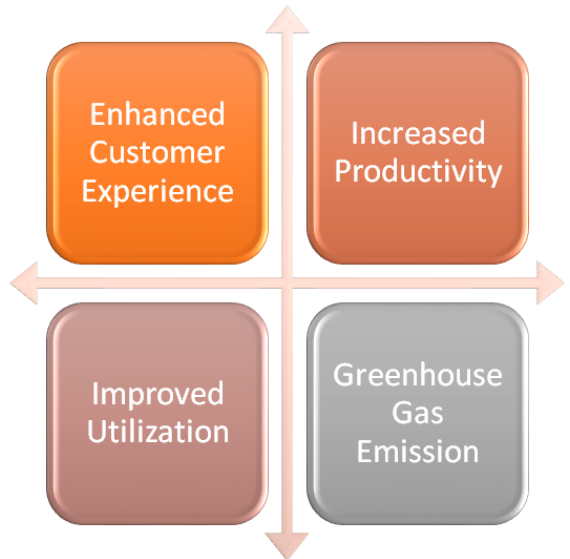
Figure 11. Motivation overview.